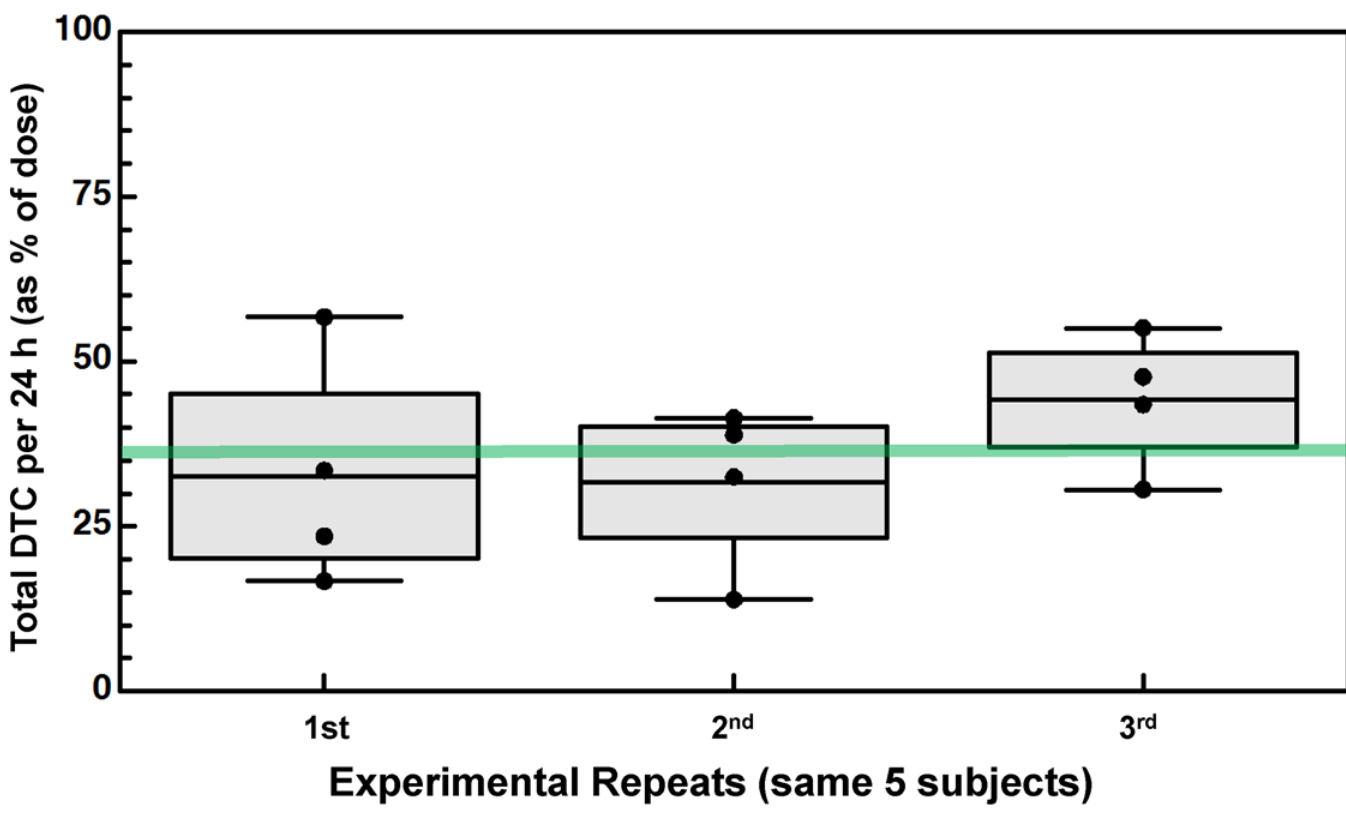
Fig 4. Mean daily excretion / conversion of broccoli seed powder (BSdP) containing active myrosinase, to SF metabolites. Preparations were delivered in standard gel-caps. The same 5 subjects performed each test ( Table 1 , Cohort 4). There was no significant difference between replications (p = 0.3747 using a repeated measures analysis of variance). The mean conversion of all 3 replicates was 36% of dose.